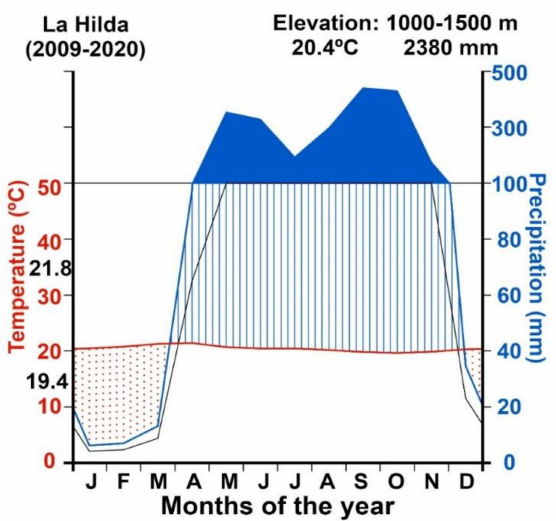
Figure 3. Climate diagram of la Hilda study site in San Pedro de Po á s, Alajuela, Costa Rica; average for the 2009–2019 period. The ordinate represents the monthly mean temperature and black numbers on the temperature axis correspond to mean daily minimum and mean daily maximum values within the total period. The solid blue shaded area represents months with more than 100 mm rainfall. The red dotted area represents dry